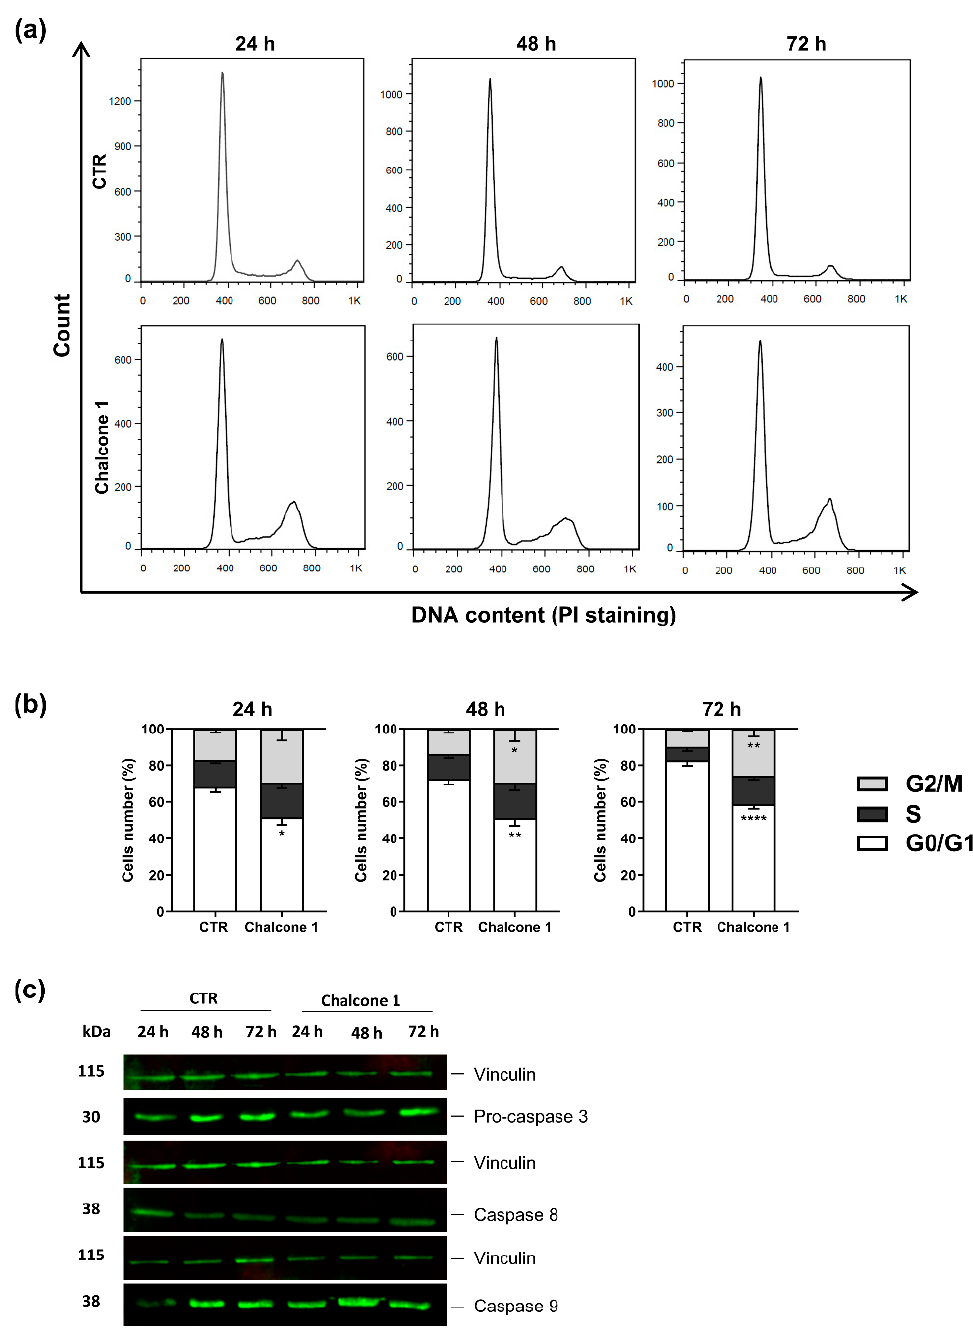
Figure 5. Cell death mechanisms induced by chalcone 1 . ( a ) Cell cycle profile of U87 cells treated or not (control—CTR) for 24, 48, and 72 h with chalcone 1 24 h IC 50 concentration. ( b ) Quantification of cells in different phases of the cell cycle after treatment. ( c ) Representative immunoblot of U87 cells treated with chalcone 1 . Results are presented as mean ± SD of three independent experiments. * p < 0.05, ** p < 0.01, **** p < 0.0001 compared to